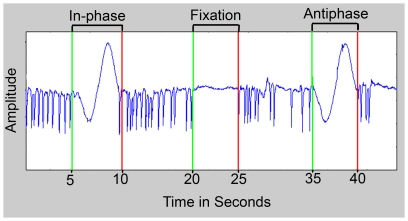
Eye movement data.Original eye movement traces for all three conditions: “SPEM with in-phase auditory target”, “Fixation with moving auditory target” and “SPEM with antiphase auditory target”.